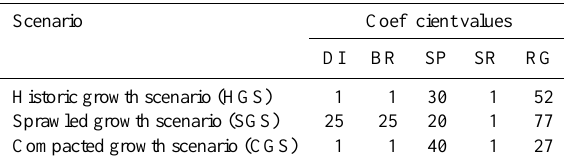
Table 5. Prediction coefficient values for different